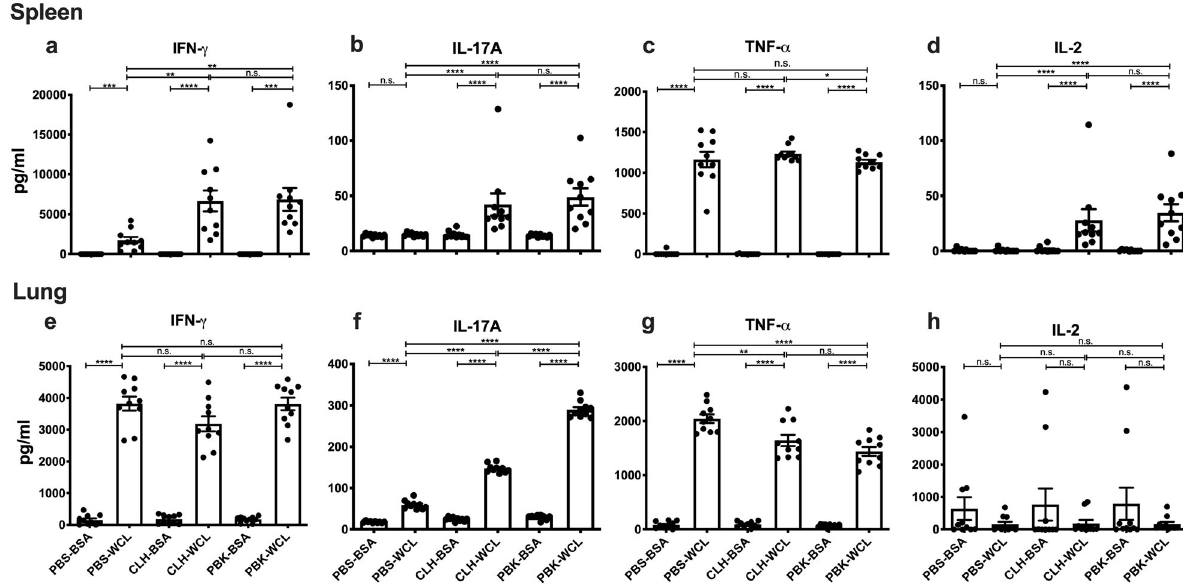
Fig. 3 Respiratory immunization with CLH001 and PBK001 generates spleen and lung populations with cytokine recall to Bpm . C57BL/6 mice were inoculated with PBS (control), CLH001, or PBK001. Bone marrow-derived dendritic cells (BMDC) were pulsed with 1 μ g WCL of Bpm K96243 or BSA (10 ug) as mock antigen. Spleen and lung were harvested at 21 days post vaccination, and mononuclear cells were isolated from disrupted organs. BMDC were overlaid with organ mononuclear cells and cultured at 37 °C and 5% CO 2 . Culture supernatants were harvested after 72 h co-culture with mock- or Bpm- pulsed BMDC. The production of cytokines in spleen ( a – d ) and lung ( e – h ) was measured by ELISA. Data are representative of mean ± SEM from 10 mice/group. Group comparisons were analyzed using t -test or Mann – Whitney test (* p < 0.05, ** p < 0.01, *** p < 0.001, **** p < 0.0001, n.s. = not signi fi